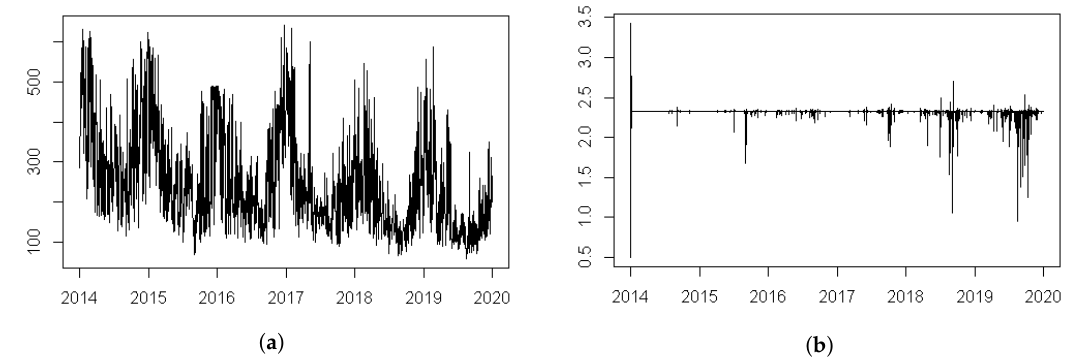
Figure 7. ( a ) The graph of fitted σ t and ( b ) the graph of fitted α t resulted from the DCW model.